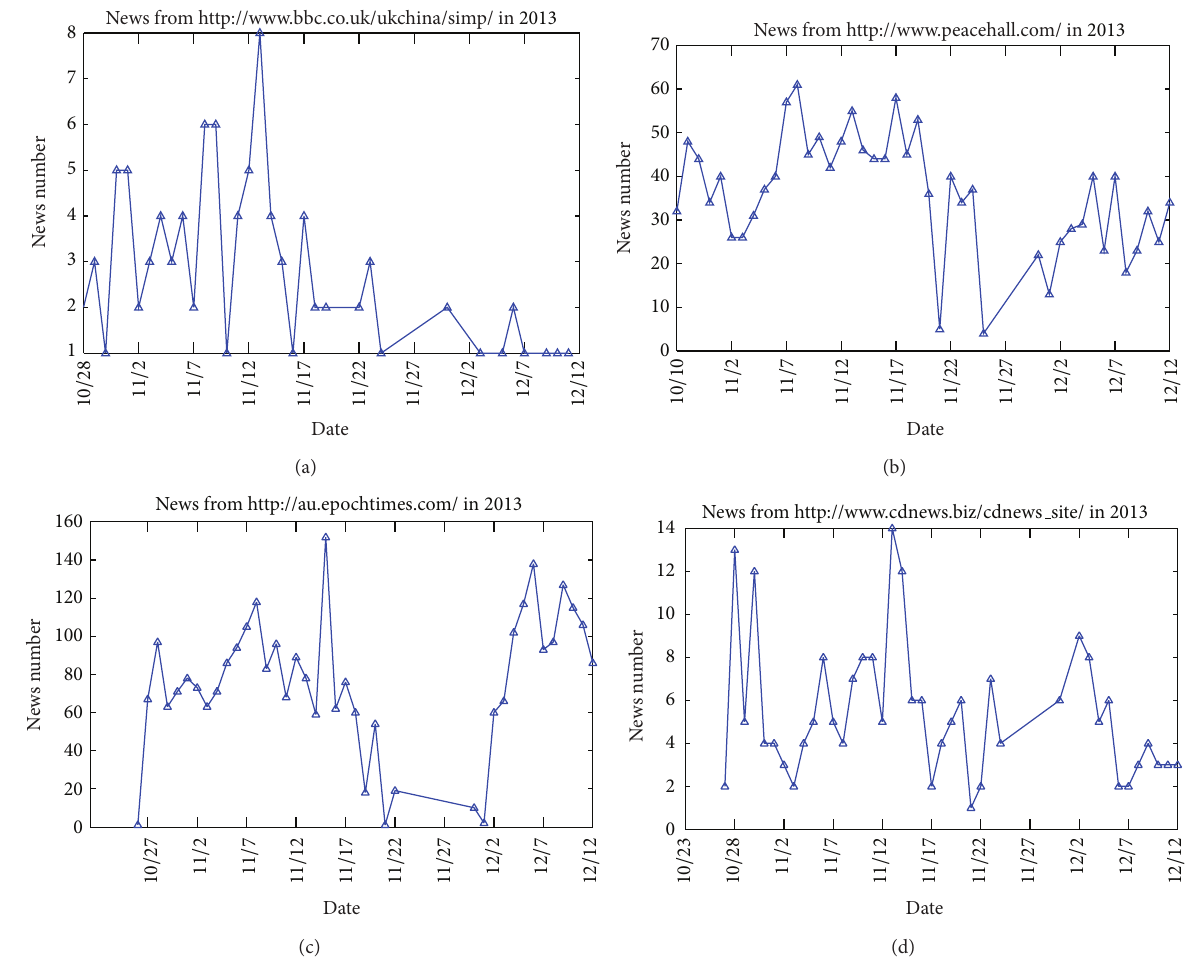
Figure 4: Relationship between news number and time for 4 different websites.